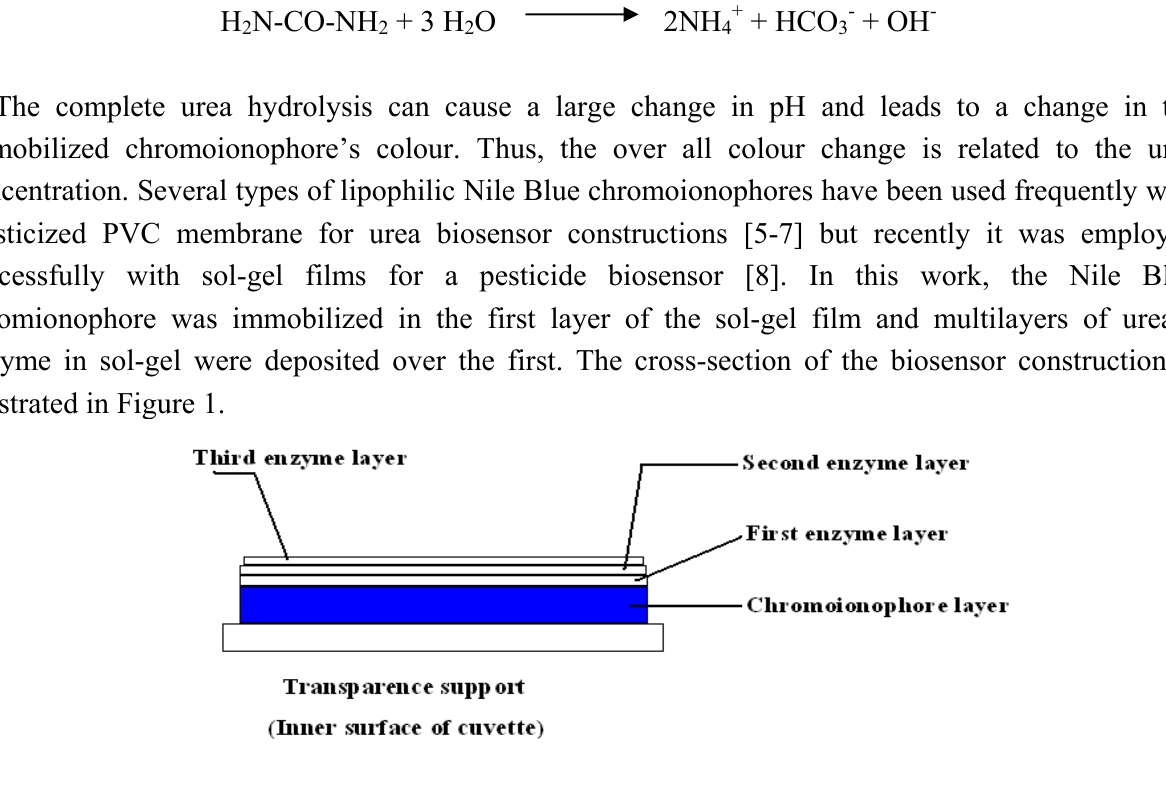
Figure 1. The cross-section of a urea biosensor based of stacked sol-gel